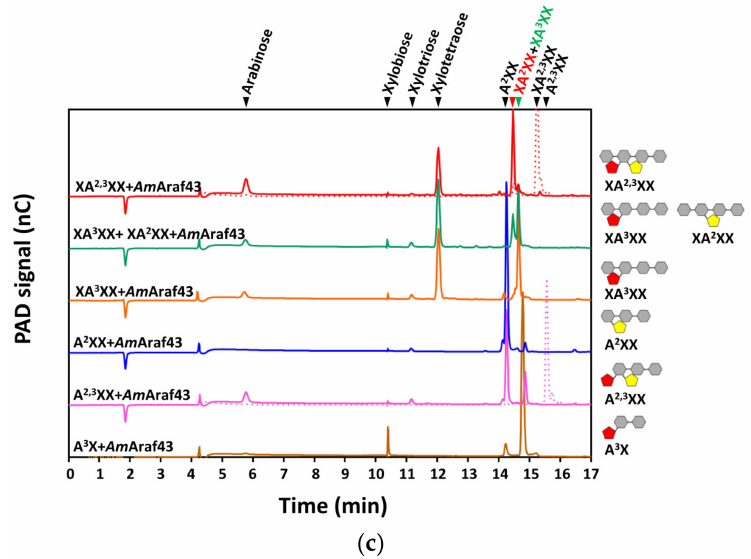
Figure 6. HPAEC-PAD analysis and structures of the hydrolysis products released from the ( a ) linear XOS by Am Araf51, ( b ) AXOS (branched XOS) by Am Araf51 and ( c ) AXOS by Am Araf43. Standard reactions were performed by incubating 85 nM Am Araf51 or 82 nM Am Araf43 with 0.25% of different XOS at 60 ◦ C and pH 6.0 for 24 h for Am Araf51 and at 40 ◦ C and pH 5.0 for 24 h for Am